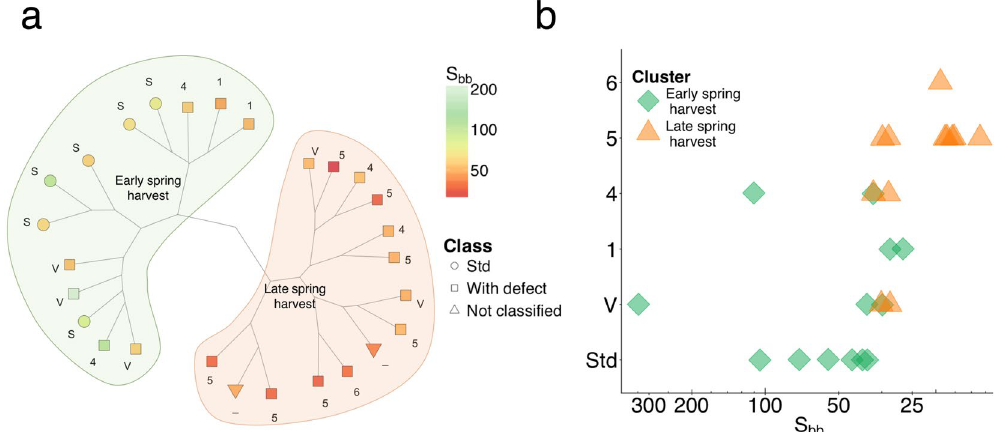
Figure 2. Yeast fitness profiles shift according to dormancy release and maple syrup quality. ( a ) Constellation plot (Hierarchical clustering, Ward’s method) of the yeast fitness collection profiles of sap samples from 2016 showing a partition between Std and class 5 samples. Branch length represents square root distances while color and shape represent S bb and sample quality, respectively. ( b ) Sap defects are not randomly distributed over the dormancy release period. Buddy defects appear after a turning point coinciding with the clustering based on yeast fitness profiles. Color and shape represent clusters defined in ( a ).